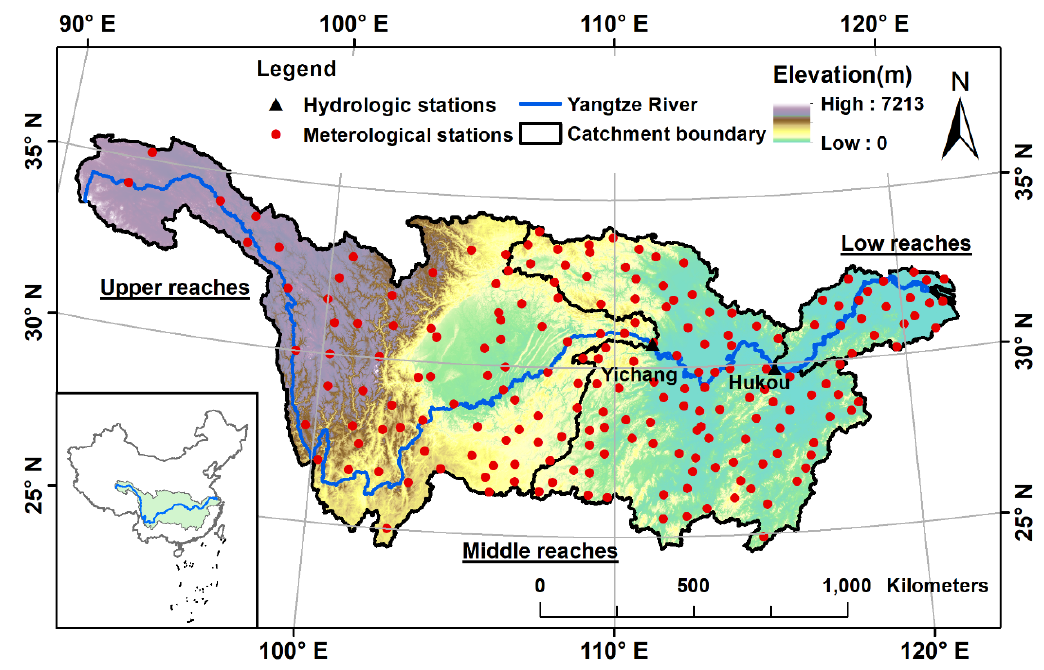
Figure 1. The geographical location of the Yangtze River Basin and meteorological stations.